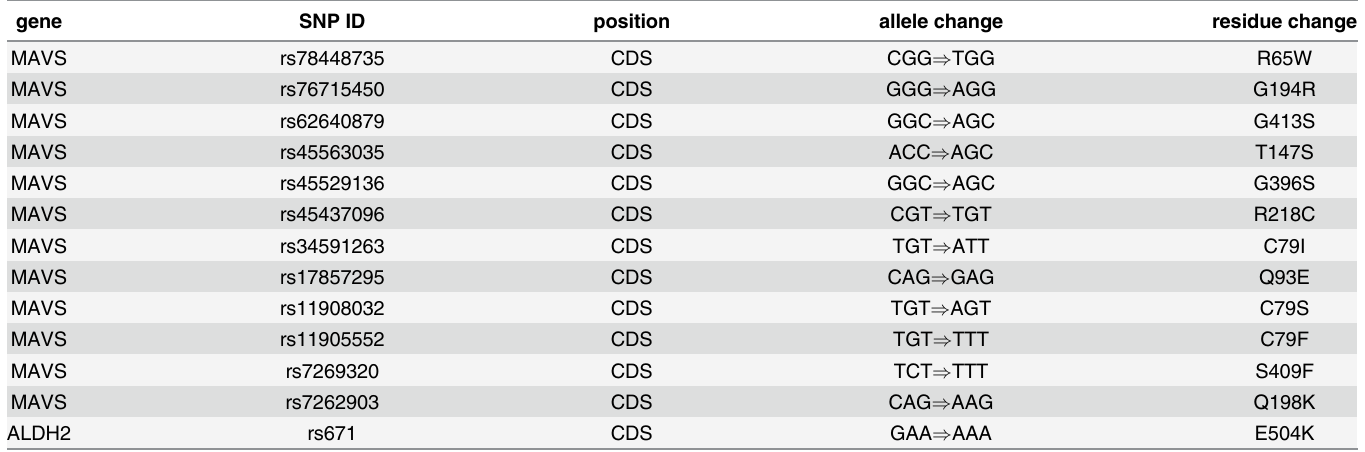
Table 6. SNPs analysed in this